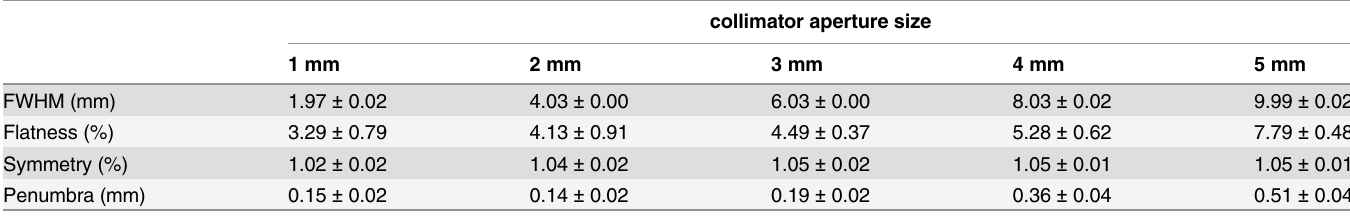
Table 1. FWHM, flatness, symmetry, and penumbra for all collimator aperture sizes at a depth of 1 mm measured using EBT3